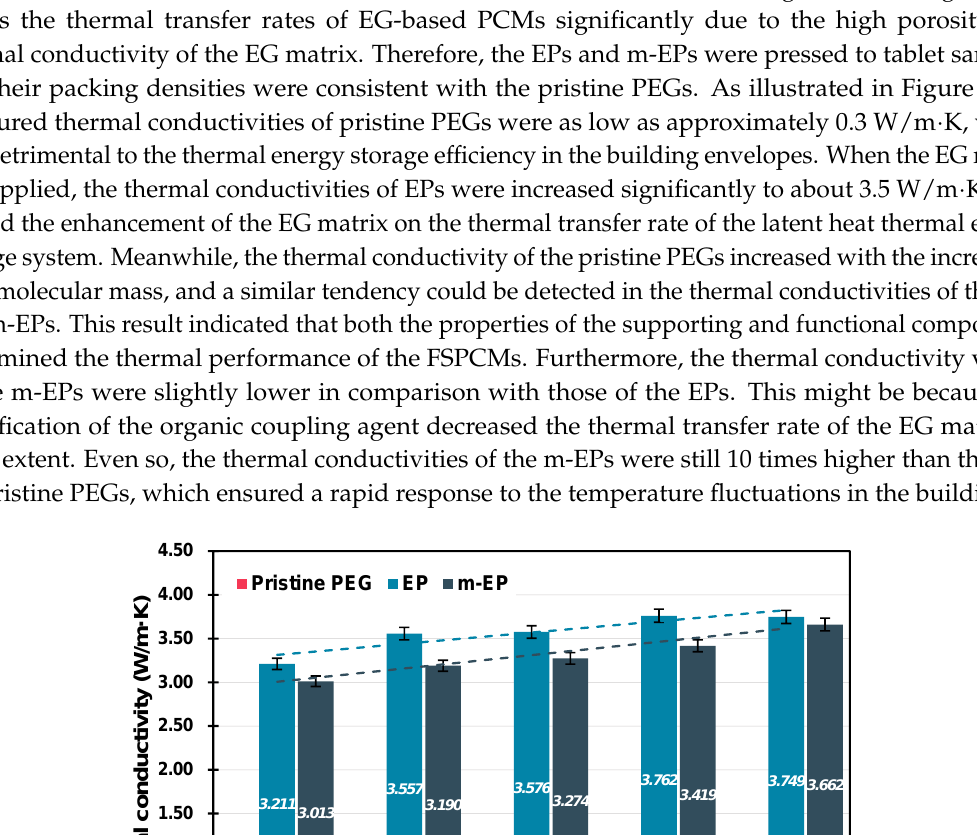
Figure 8. Thermal conductivity of PEGs, EGs, and m ‐ EGs at the same packing density.